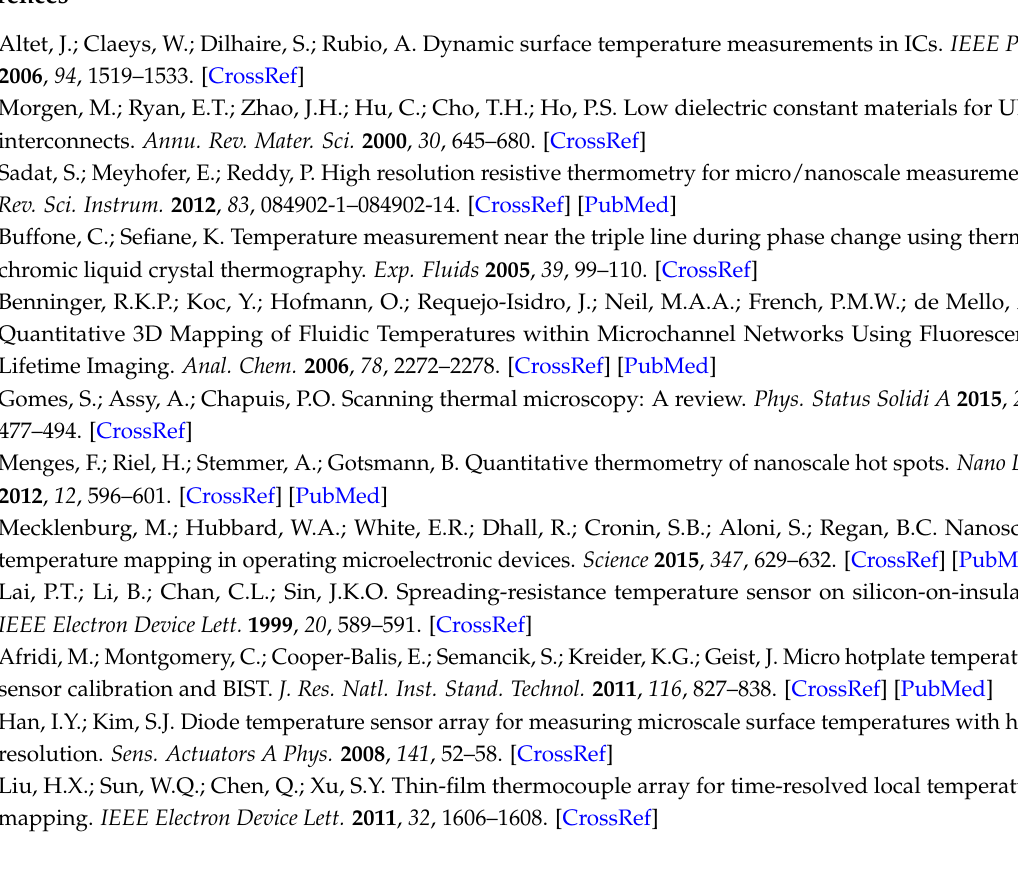
Figure S1: An optical top-view photography of the hybrid electrical-mechanical multiplexer used in this work. (a) Connector to host PC; (b) Controller for relays; (c) Manual keys for reset of the controller; (d) LED Display; (e) Driver; (f) Relay matrix; (g) Connector to sensors; (h) Connector to nanovoltmeter, Figure S2: A schematic flow chart of the design and working mechanism whole measurement system. The dashed yellow frame indicates what are consisted in the multiplexer board, Figure S3: Typical calibration results of 8-cm long, Cr/Pt thin-film thermocouples, measured on a static calibration platform. The data are measured after the sample temperatures are stabilized at both hot and cold ends, which takes about 10 min for each data point. The fitting curve gives a nominal thermopower of 14.87 µ V/K, Figure S4: Calibration results for one sensor in the sensing array, where the heater tip touches directly over the junction region with a thin buffer layer of dried super glue. Heat partially dissipates from the tip-touching point to the glass substrate. Linear fitting of the measurement data gives a nominal thermopower of 9.83 µ V/K, Figure S5: Calibration results for one sensor in the sensing array, where in measurement the heater tip touches the substrate 300 microns away from the junction region. Due to strong dissipation of heat from the tip-touching point to the glass substrate, the linear fitting of the measurement data gives a nominal thermopower of only 4.99 µ V/K, Video S1: Original video for Figure